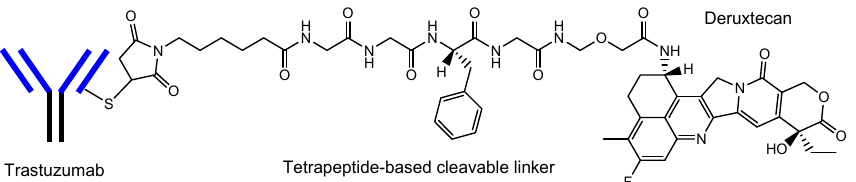
Figure 4. The structure of trastuzumab deruxtecan (Enhertu ® ), with a drug-to-antibody ratio (DAR) of 7.7. of